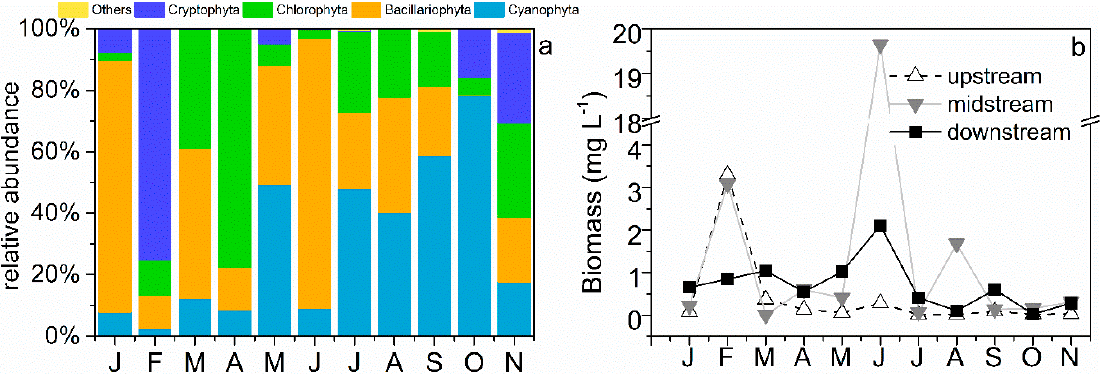
Figure 5. Relative abundance ( a ) and calculated biomass ( b ) of phytoplankton in the reservoir. Phytoplankton in the Qingcaosha Reservoir had one or more species dominant in different seasons. We identified four dominant species in the reservoir according to relative abundance value, they were diatoms M. granulata (16.0%), Melosira granulata var. angustissima (20.3%), M. varians